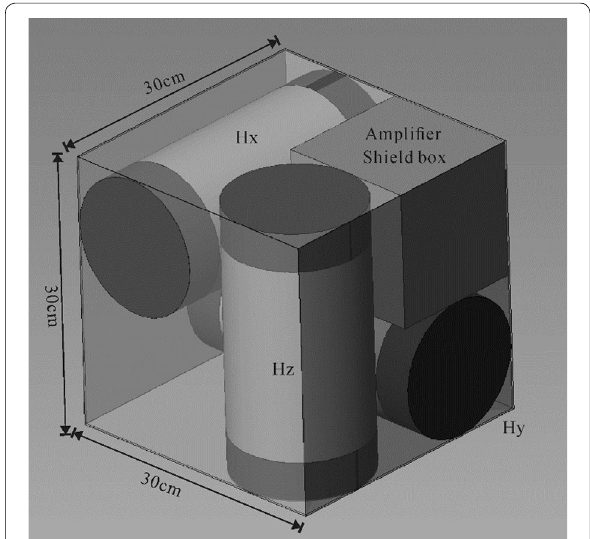
Fig. 5 Block diagram of the triaxial induction coil